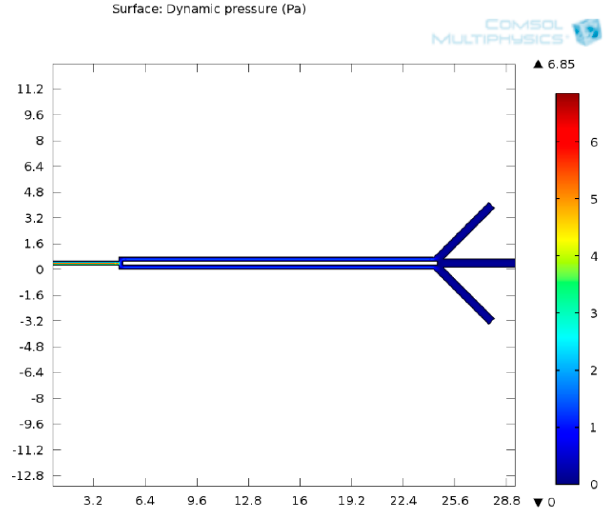
Figure 8. Surface plot of fluid dynamic pressure.